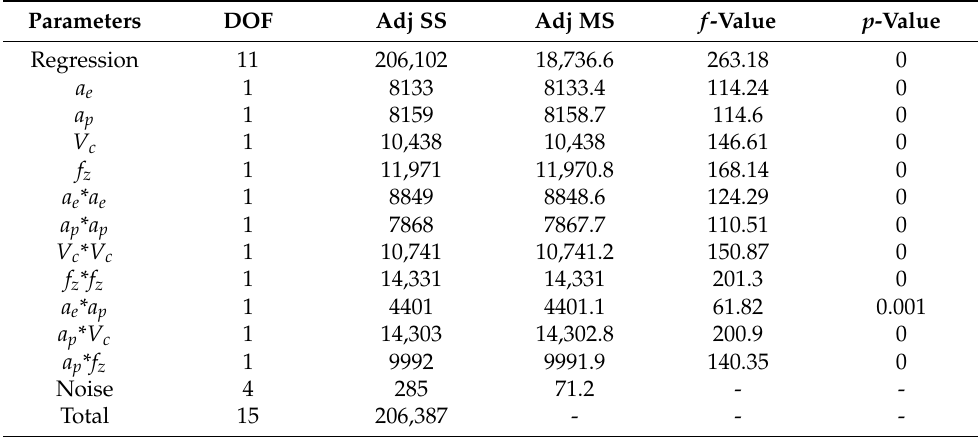
Figure 8. Experimental data [L 16 (4 4 )] and fitting results of maximum cutting temperature T . Table 4. ANOVA for maximum cutting temperature.